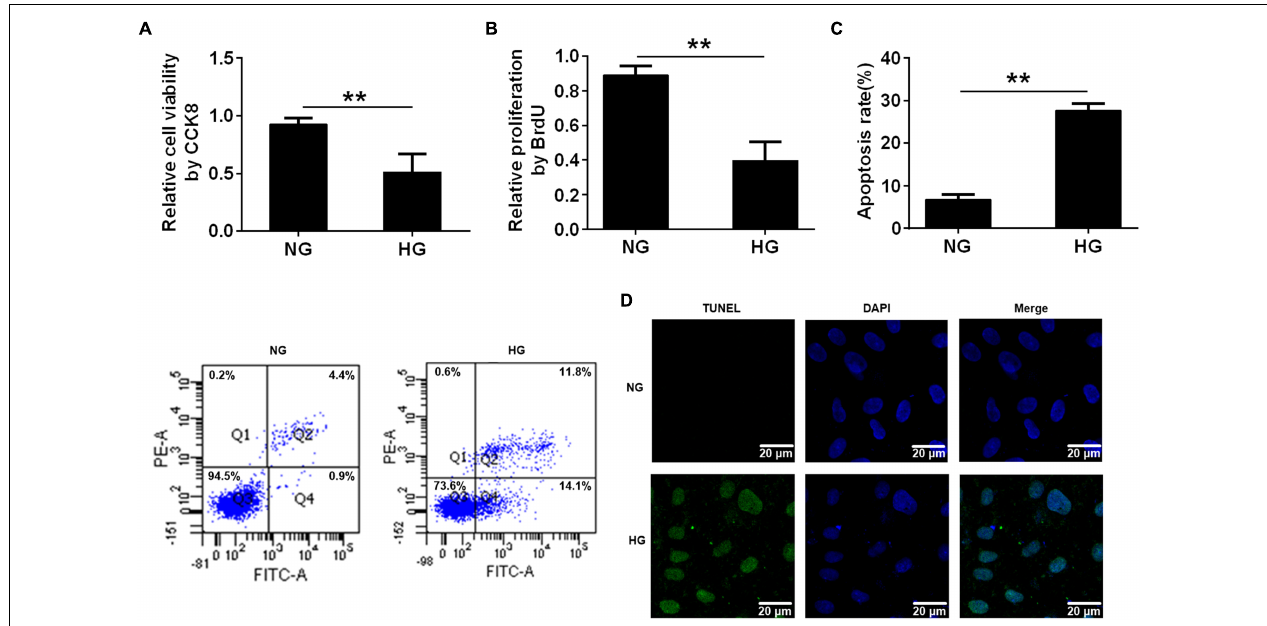
FIGURE 1 | High glucose reduced cell proliferation and induced cell apoptosis. (A) CCK8 assay for cell viability in HUVECs treated with NG (5.5 mmol/l) and HG (33.3 mmol/L) for 24 h. (B) BrdU incorporation assay of cell proliferation in HUVECs treated with NG and HG. (C) Annexin V/PI assay of cell apoptosis in HUVECs treated with the NG and HG conditions. The histograms represent the apoptosis rates in the two groups. (D) Representative photographs of TUNEL staining in the different groups. The results are expressed as the means ± SD. ∗∗ p < 0.01; two-tailed Student’s t